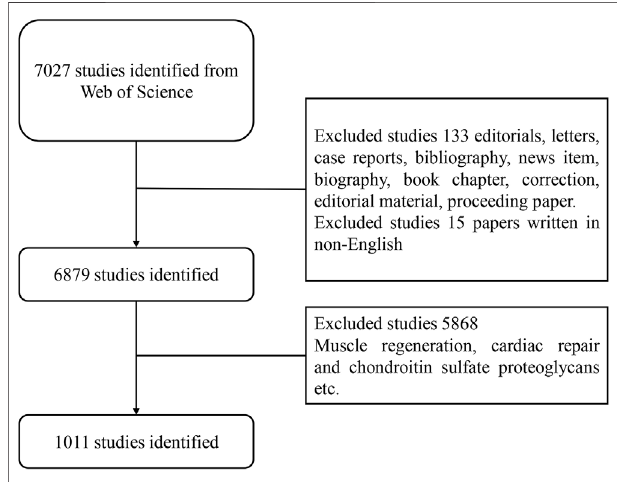
FIGURE 1 | Flow chart of the screening process for research on stem cells for